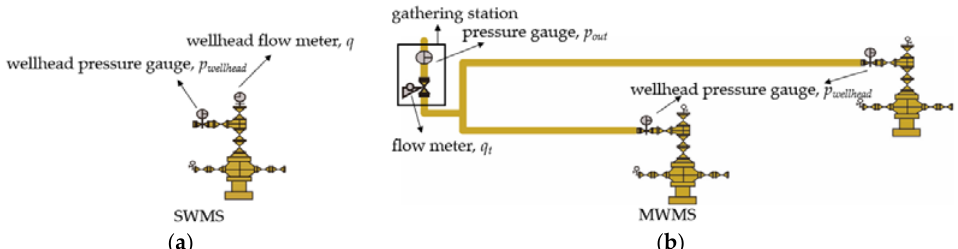
Figure 1. The schematics of the ( a ) single-well-monitor system (SWMS) and ( b ) multi-well-monitor system (MWMS).